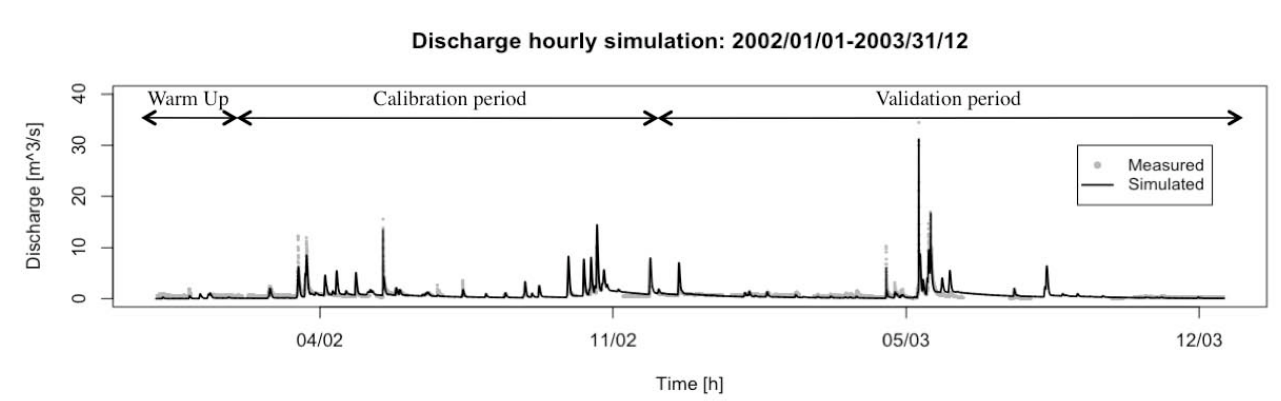
Fig. 8. Test B: application of the JGrass-NewAge model for the period 01/01/2002 to 31/12/2003: the solid curve represents the simulated discharge, while the dots represents the measured one.